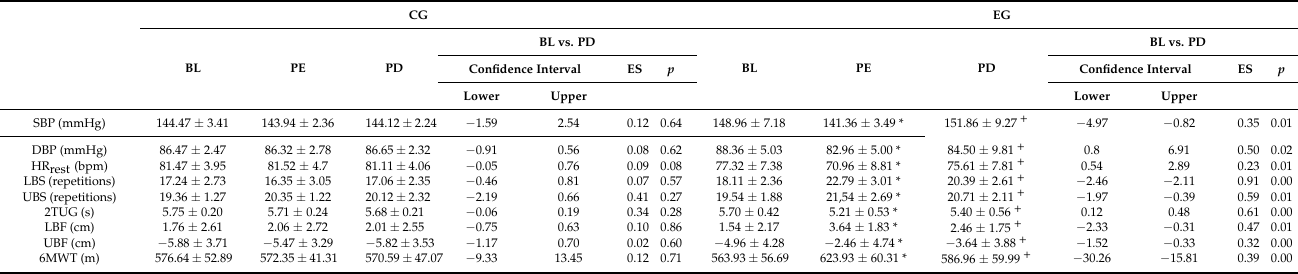
Data presented are mean ± SD; before multicomponent training (BL), post exercise (PE), and post detraining (PD) of systolic blood pressure (SBP), diastolic blood pressure (DBP), resting heart rate (HR rest ), upper body strength (UBS), lower body strength (LBS), upper body flexibility (UBF), lower body flexibility (LBF), agility/dynamic balance (2TUG), aerobic endurance six-minute walk test (6MWT). * p < 0.05, significant improvements after training period of multicomponent training program; + p < 0.05, significant decreases with detraining period after multicomponent training